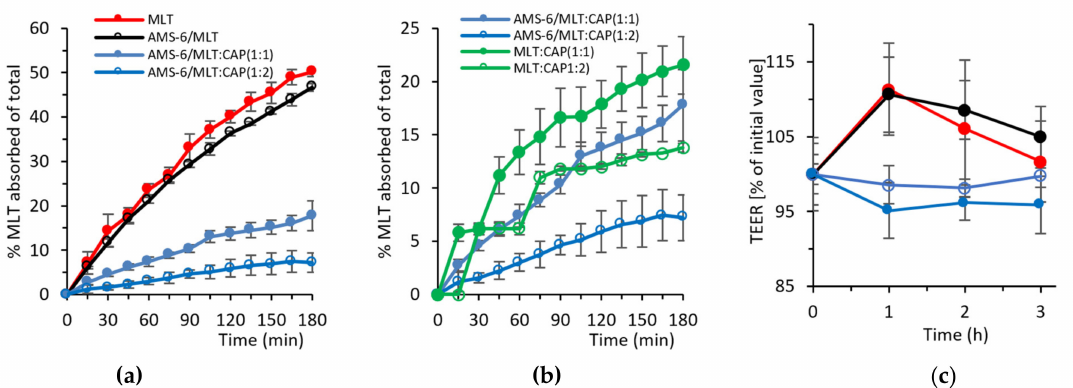
Figure 4. Absorption kinetics of mLT as a molar percentage of the total added across a Caco-2 monolayer for ( a ) mLT, AMS- 6/MLT, AMS-6/MLT:CAP(1:1) and AMS-6/MLT:CAP(1:2) and ( b ) CAP-coated mLT in the absence of AMS-6 mesoporous silica. ( c ) TEER measurements showing the Caco-2 monolayer integrity during the absorption experiments. Every data point represents the average value obtained from a triplicate sample, and the error bars correspond to the calculated standard